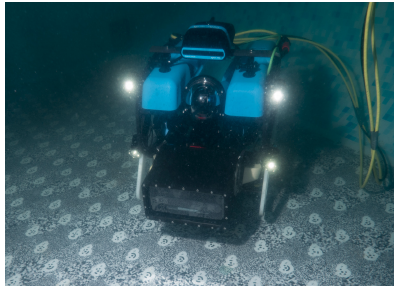
Figure 6. BlueROV2 equipped with Stereolab ZED2 and Oculus M750d sensors